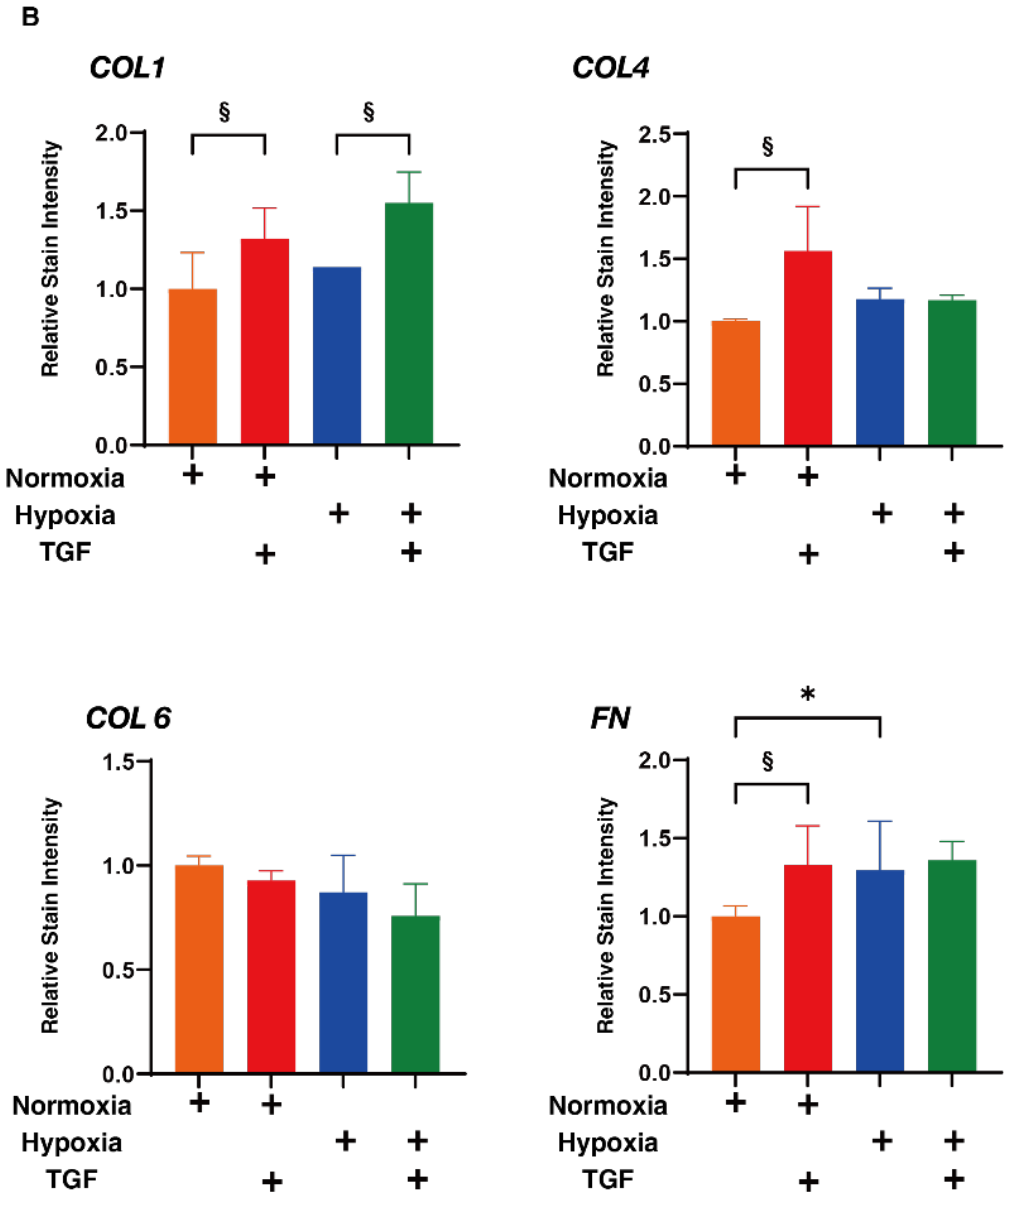
Figure 4. Immunolabeling of ECMs of the 2D cultured HRPE cells under normoxia or hypoxia conditions. 2D cultured HRPE cells at Day 6 prepared under normoxia or hypoxia conditions were treated without (control) or with a 5 ng/mL solution of TGF- β 2 (TGF), and each sample was subjected to immunostaining for COL1 , COL4 , COL6 , and FN . All experiments were performed in duplicate using fresh preparations (n = 5). Representative images (upper; merge with DAPI, lower; anti-ECM, scale bar; 100 µ m) are shown in panel ( A ) and relative staining intensities against the normoxia conditions without TGF- β 2 are plotted in panel ( B ). “+” is reagents addition. Data are presented as the arithmetic mean ± standard error of the mean (SEM). * p < 0.05 control vs. TGF, § p < 0.05 normoxia vs. hypoxia (ANOVA followed by a Tukey’s multiple comparison test).